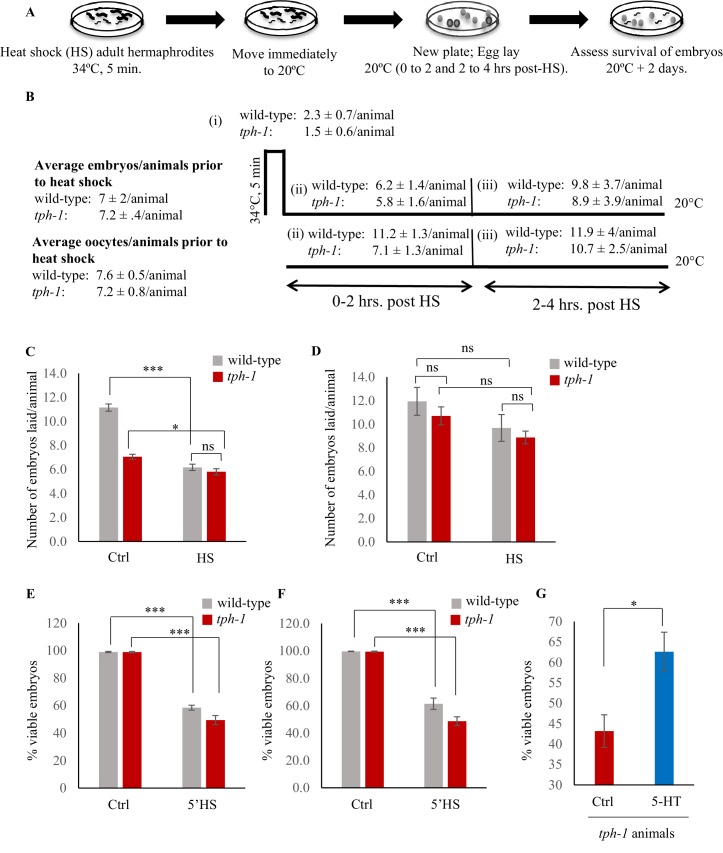
Characterizing the effects of heat on viability of embryos.(A) Schematic design of the experiment. (B) The average numbers of embryos and oocytes present per animal in wild-type animals and tph-1 mutants prior to heat exposure, and embryos laid per animal under control conditions at 20°C, (i), upon the 5 min exposure to 34°C, (ii), during 0–2 hr post-heat shock, and (iii) during 2–4 hr post-heat shock are shown. (C) Mean numbers of embryos laid per animal by wild-type animals and tph-1 mutants under control conditions at 20°C, and during 0–2 hr post-heat shock (n = 18 experiments). (D) Mean numbers of embryos laid per animal by wild-type animals and tph-1 mutants under control conditions, and 2–4 hr post-heat shock. (n = 28 experiments). (E) Percent viable embryos when embryos laid by wild-type animals and tph-1 mutant animals during a 2 hr interval were exposed to 34°C for 5 min. (F) Percent viable embryos when embryos were present in utero in wild-type animals or tph-1 mutant animals exposed to 34°C for 5 min. This was determined by assaying the viability of embryos laid during a 2 hr interval immediately after the mothers were heat-shocked. (G) Percent viable embryos laid by tph-1 mutant animals upon treatment with exogenous 5-HT compared to those laid by untreated tph-1 mutant animals. In this experiment embryos were laid by tph-1 animals 2–4 hr after a 5-min heat shock. Data in C–G show Mean ± Standard Error of the Mean. *, p<0.05; **, p<0.01 ***, p<0.001, ns = non significant; (Paired Student’s t-test).